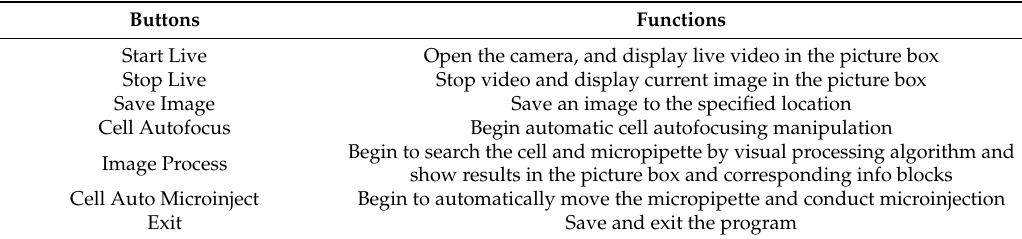
Figure 3. Visual servoing microinjection interactive interface. Table 1. The button functions of the user interface.